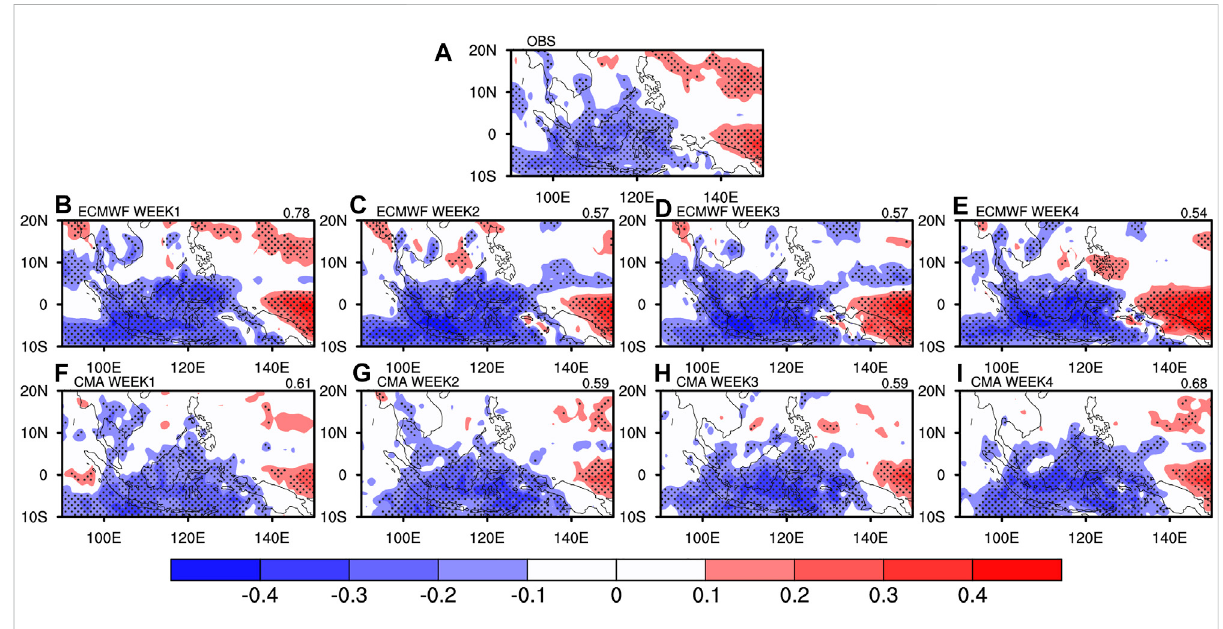
Spatial distribution of correlation coef fi cients between observed weekly mean precipitation anomalies and observed weekly mean ENSO index (A) ,togetherwiththecorrelationcoef fi cientsmapsbetweenforecastedweeklymeanprecipitationanomaliesandforecastedENSOindexinECMWF (B – E) and CMA (F – I) at the lead time of 1 – 4 weeks. The pattern correlation coef fi cients between observed correlation coef fi cients maps and forecasted correlation coef fi cients maps are also provided on the right strings. Stipples indicate correlations statistically signi fi cant at the 95% level.